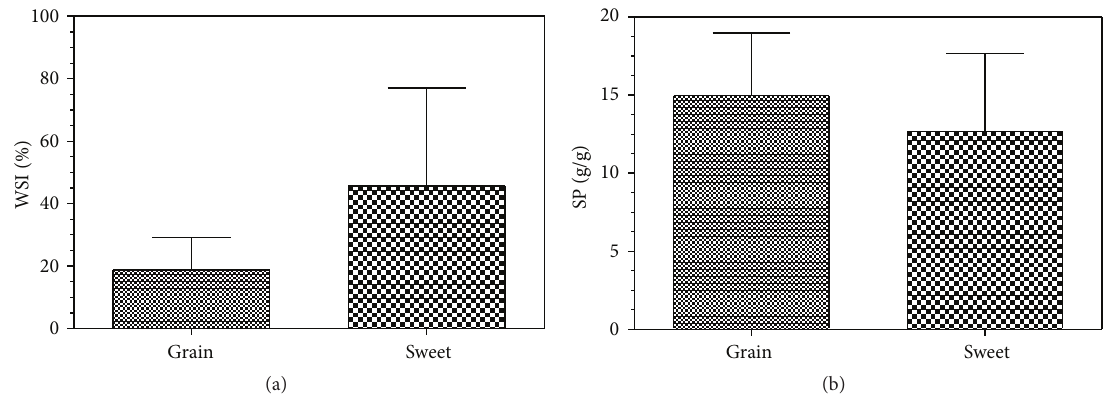
Figure 2: Comparison of water solubility index (WSI) (a) and swelling power (SP) (b) between sweet and grain sorghum varieties starch. No significant difference was noticed ( 𝑝 < 0.05